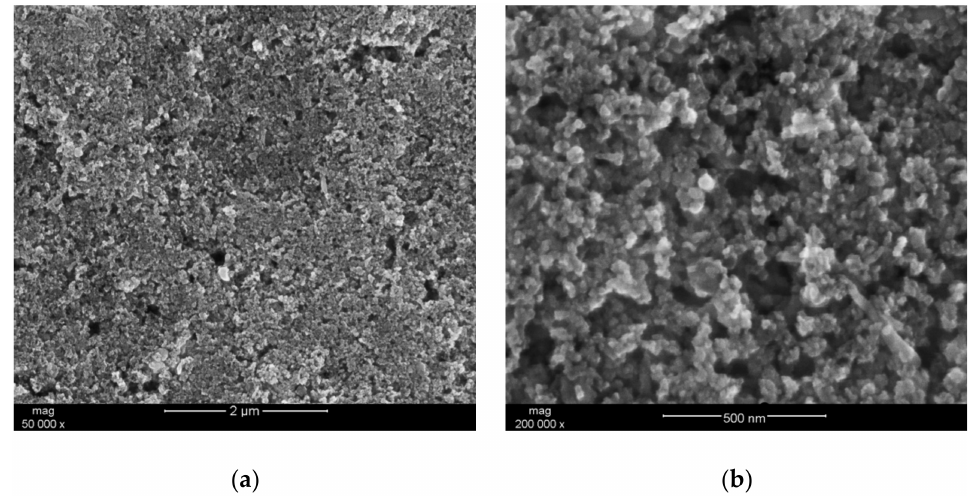
Figure 1. SEM (Scanning Electron Microscope) scan depicting the morphology of hydrous iridium dioxide layer. ( a ) 50,000 × magnitude; ( b ) 200,000 ×